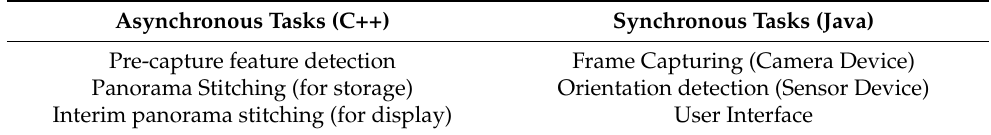
Table 2. Implementation details of the different